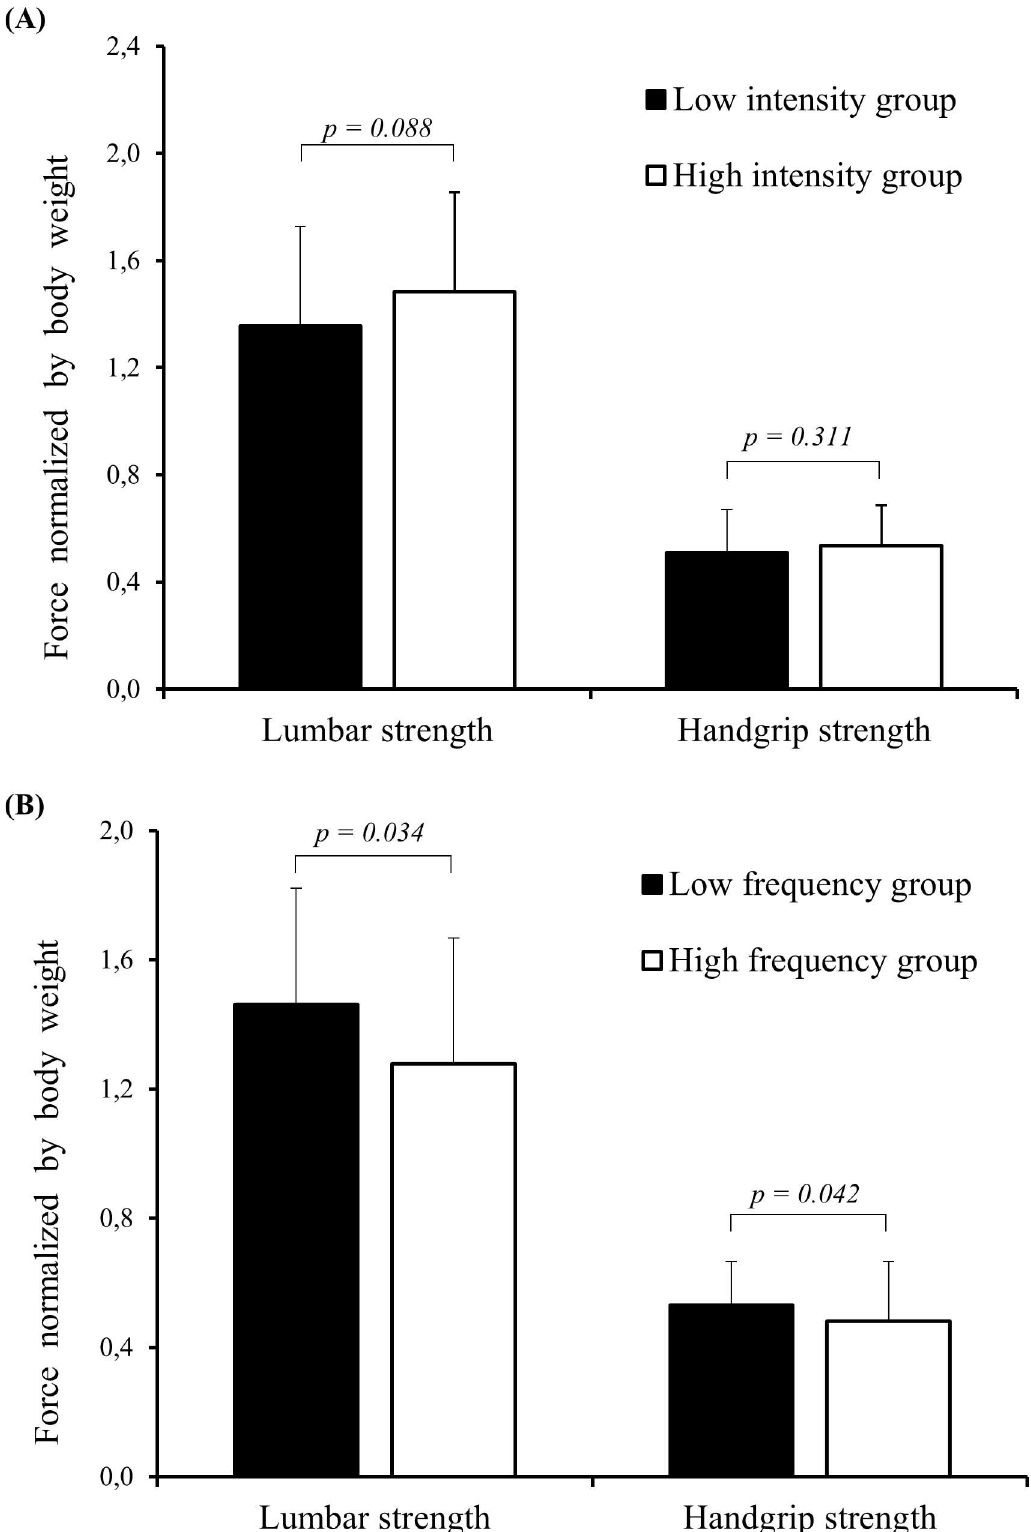
Fig 2. Handgrip and lumbar strength stratified according to back pain intensity (A) and back pain frequency (B). Independent t test was used for lumbar strength analysis. Mann-Whitney U test was used for handgripstrength